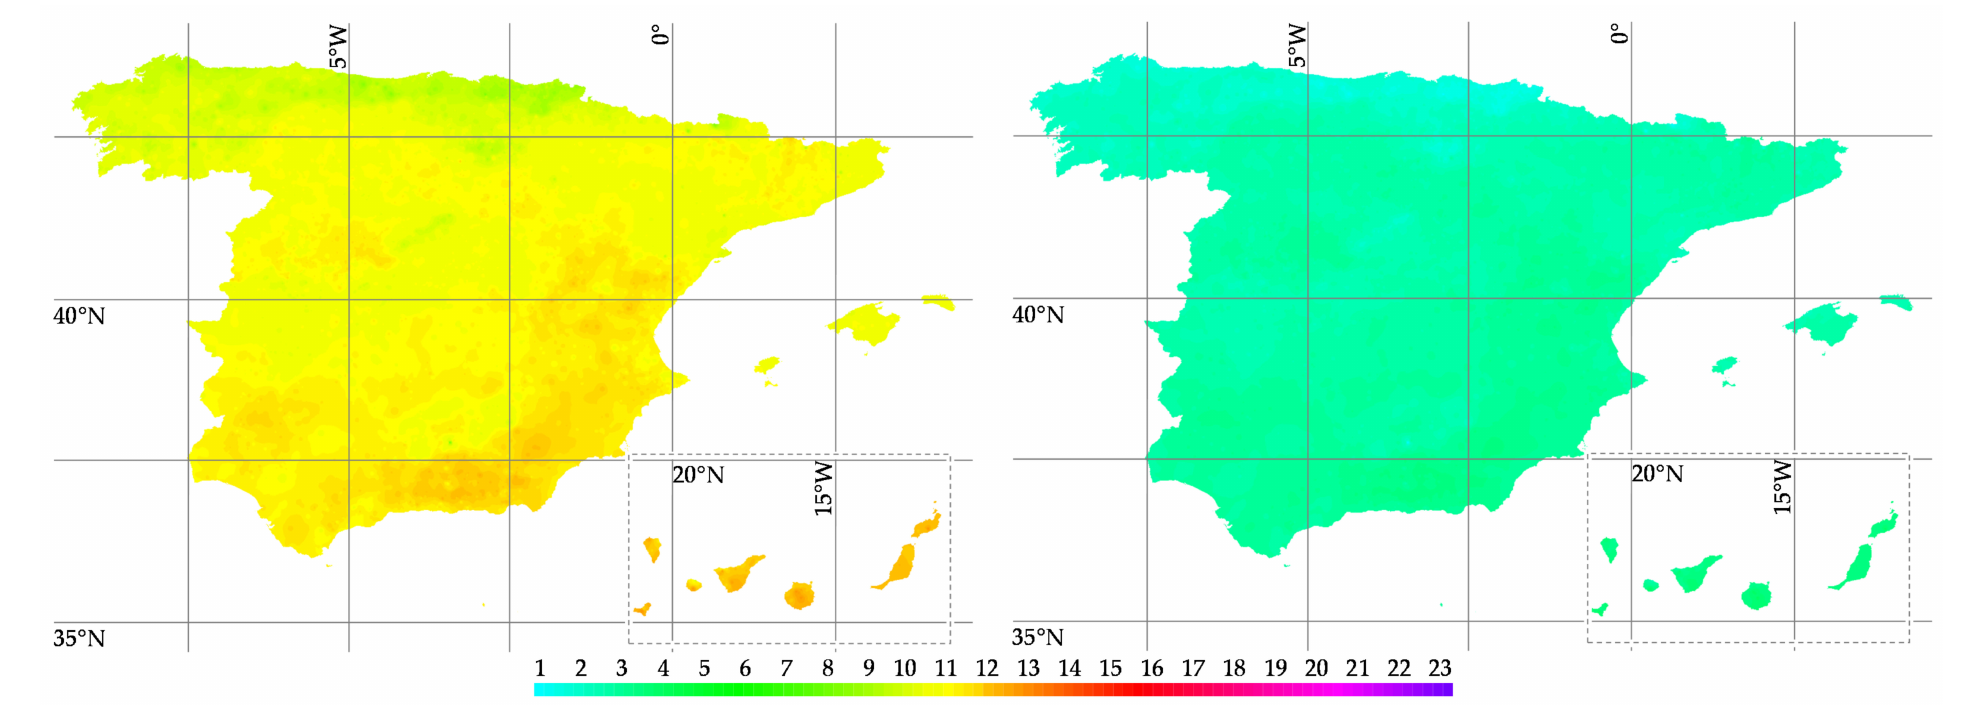
Figure 7. ST IRR in % (S3 (auxiliary electricity supply scenario) left , S4 (auxiliary natural gas supply scenario) right ).